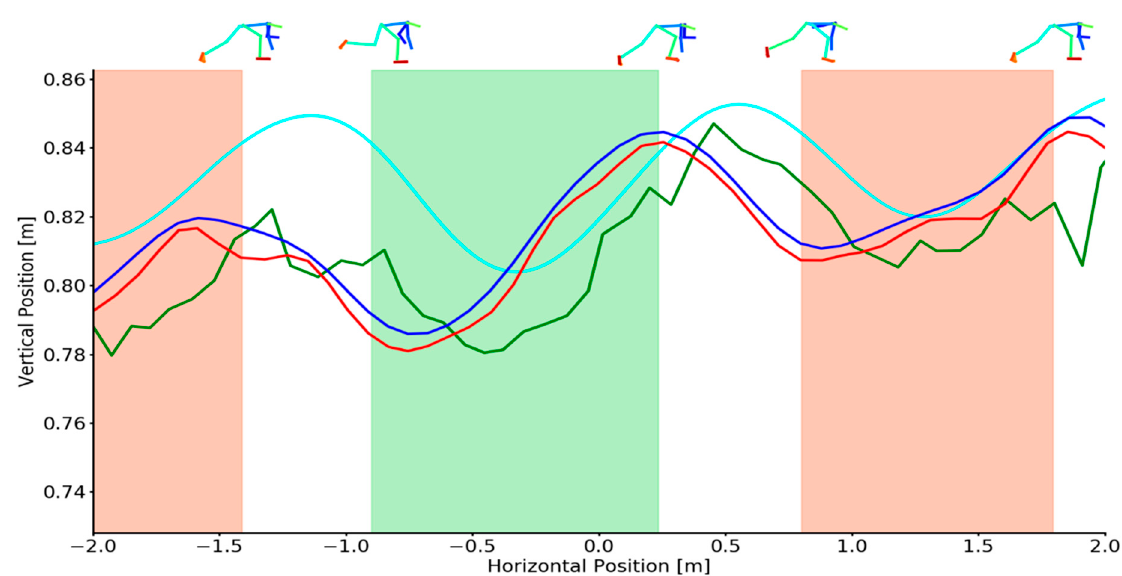
Figure 4. Example individual trial demonstrating sagittal plane CoM positions for criterion (cyan), unfiltered (green), low-pass filtered (red) and Kalman smoothed (blue) data during pushing. Shaded areas depict the left foot (red shading) and right foot (green shading) stance phase. Footfall events were computed from marker-based foot kinematics [32] . OpenPose joint centre reconstructions (top) at touch-down and toe-off events are overlaid for context.